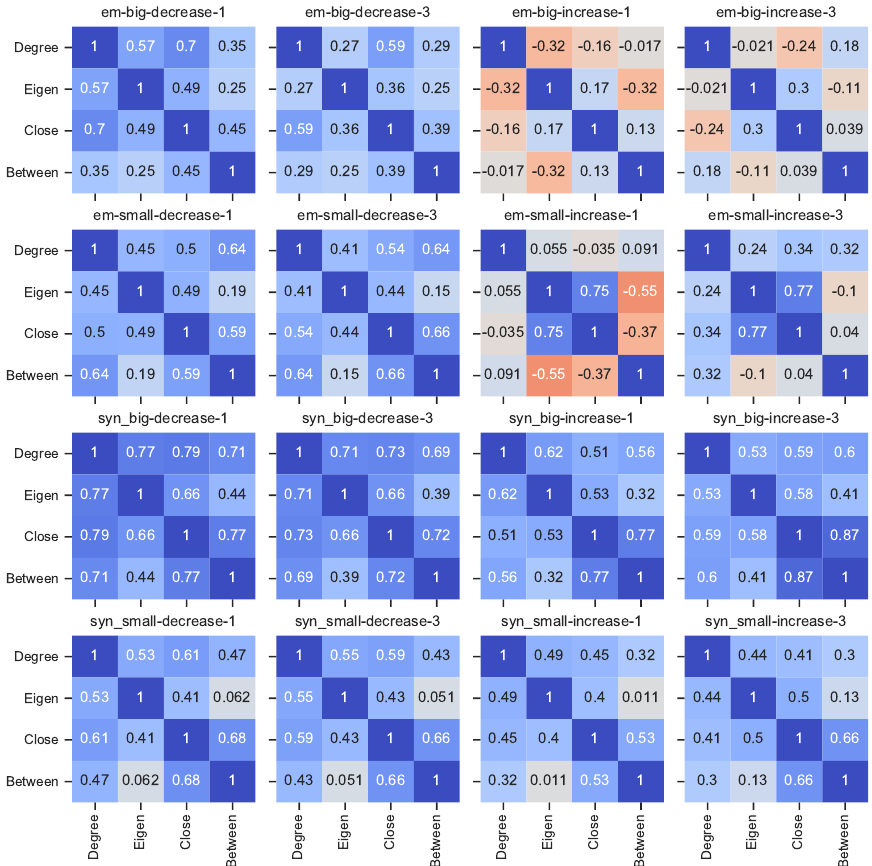
Figure 9. Heat map of correlation between change in target node centrality ranks (percentiles) for all four centrality measures per network size and origin. Syn stands for synthetic networks and em stands for empirical networks. 1 indicates local reach type and 3 indicates global reach